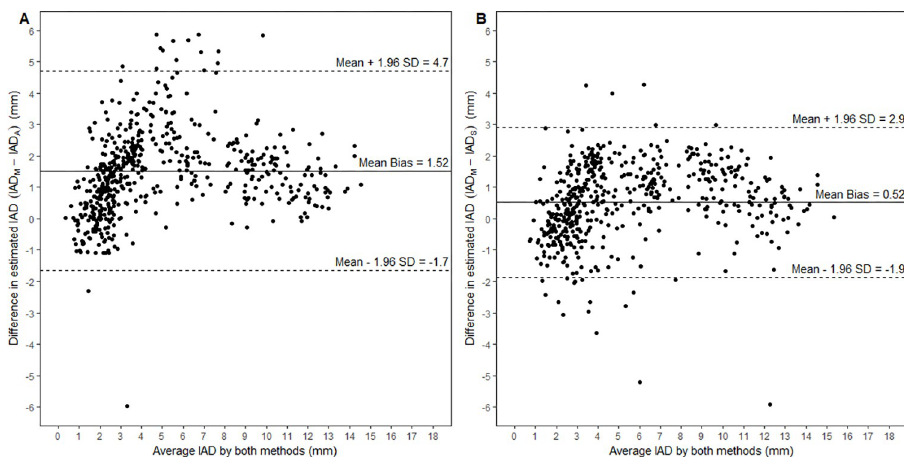
Fig 3. Bland-Altman plots. 3A compares the IAD M against the IAD A , while 3B compares IAD M to the IAD S . The mean bias (solid line), 95% upper and lower limits of agreement (dotted lines) are